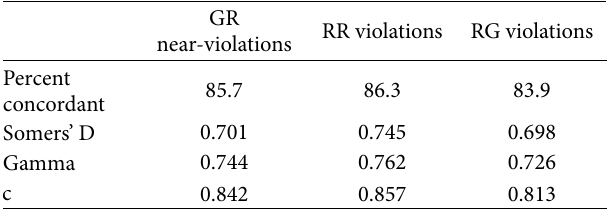
Table 7: Association of the predicted probabilities and the observed